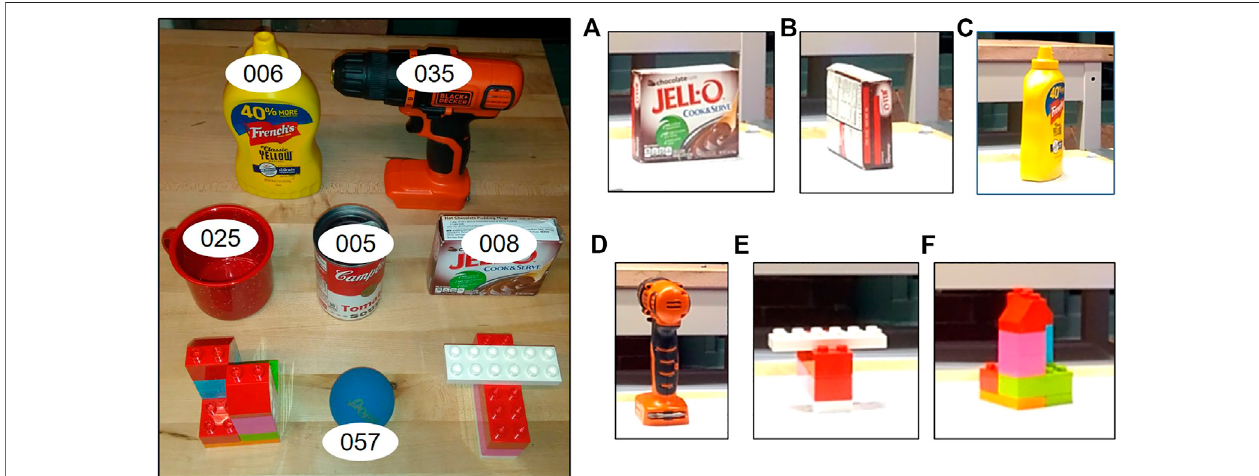
FIGURE 12 | The left image shows the set of objects used for real world testing along with their YCB IDs. On the right are the stable poses used for testing (The manipulator base is towards the right). (A) [YCB ID : 008] Stable Pose \#1, (B) [YCB ID : 008] Stable Pose \#2, (C) [YCB ID : 006] Stable Pose \#1, (D) [YCB ID : 035]